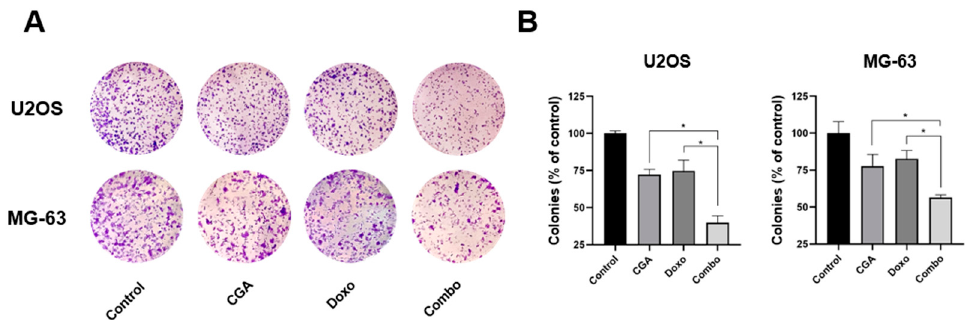
Figure 3. Estimation of CGA, Doxo, and CGA plus Doxo induced colony-forming ability in OS cells. U2OS and MG-63 were treated and not (control) with 20 µ M (U2OS) or 40 µ M (MG-63) CGA, 0.005 µ M Doxo, and CGA plus Doxo (combo); thereafter, clonogenic ability was assessed by crystal violet staining. Representative experimental images are displayed in panel ( A ). Quantification analysis from three different experiments has been carried out and reported in panel ( B ). * p < 0.05.